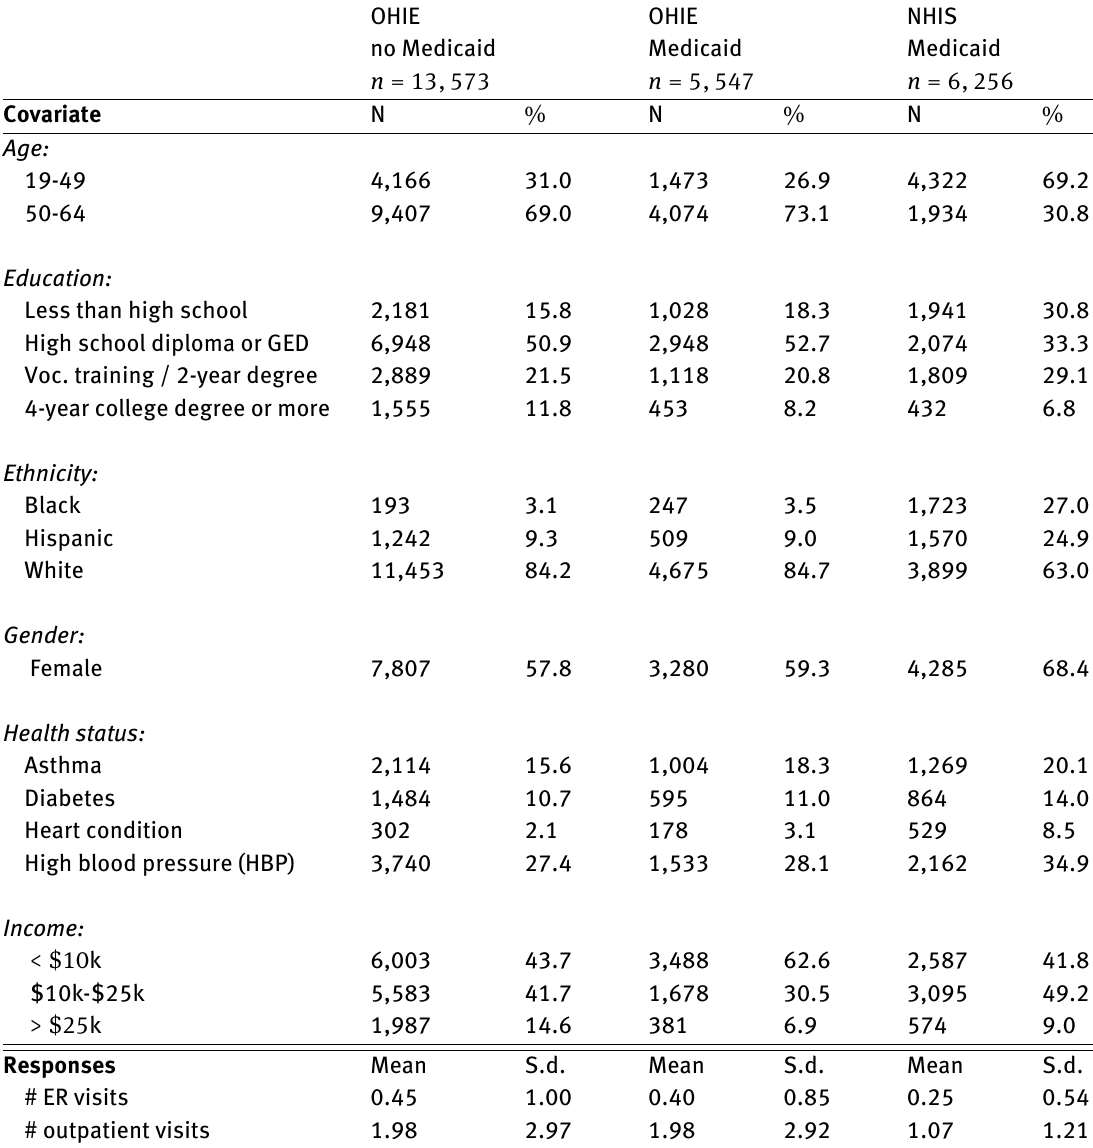
Table B2: Pretreatment covariates and responses for OHIE and NHIS respondents by Medicaid coverage status.